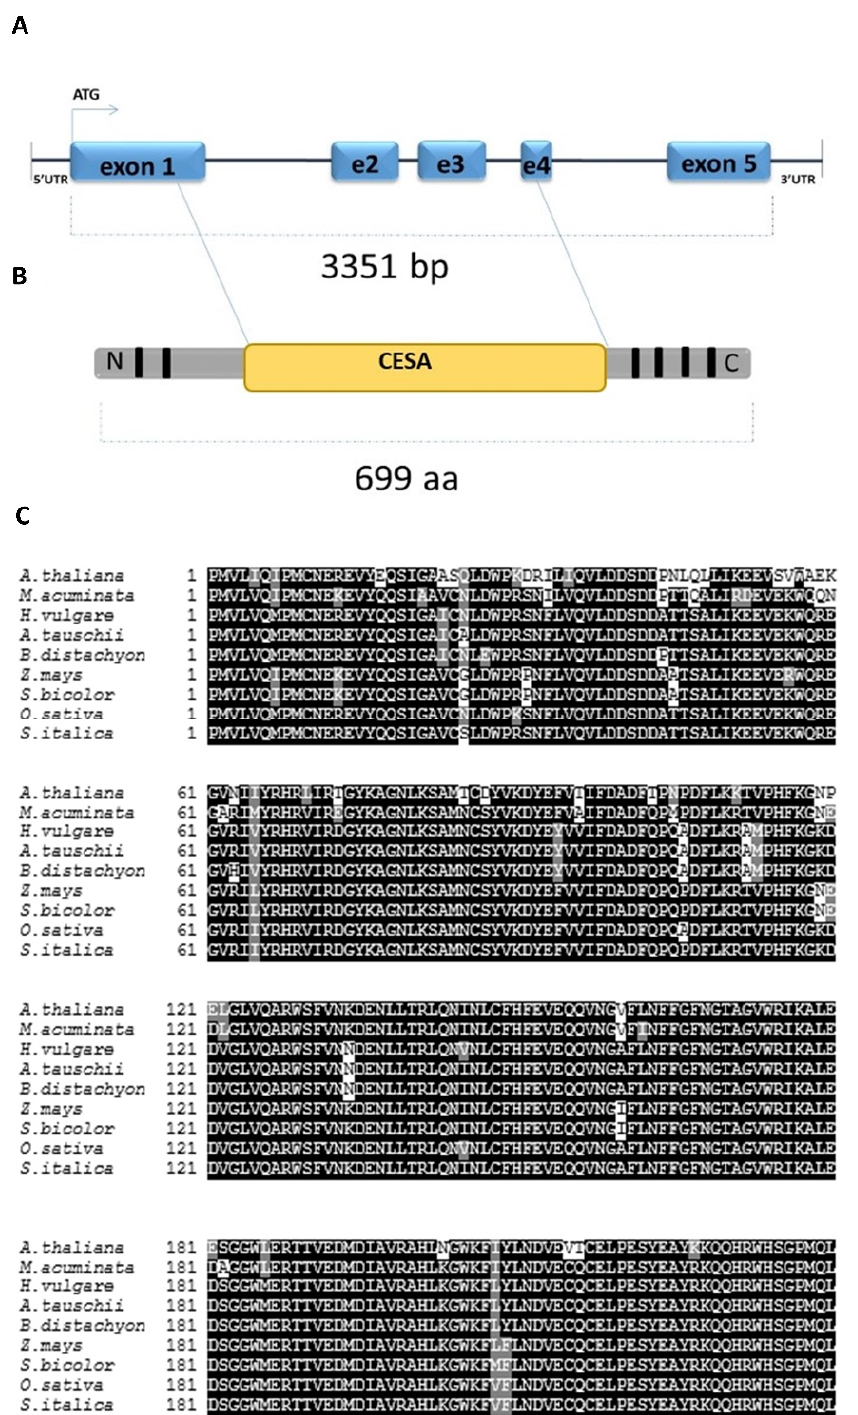
Figure 2. ( A ) The structure of HvCSLC1 gene and ( B ) the scheme of HvCSLC1 protein. Blue boxes and lines in ( A ) represent exons and introns, respectively. Black boxes in ( B ) indicate the location of transmembrane domains (TDMs), blue—the cellulose synthase domain CESA. ( C ) The alignment of the CESA domain of HvCSLC1 protein sequence in H. vulgare , Arabidopsis thaliana , Musa acuminata , Aegilops tauschii , Brachypodium distachyon , Z. mays , Sorghum bicolor , O. sativa and Setaria italica . The black regions indicate the highly conserved amino acid residues.